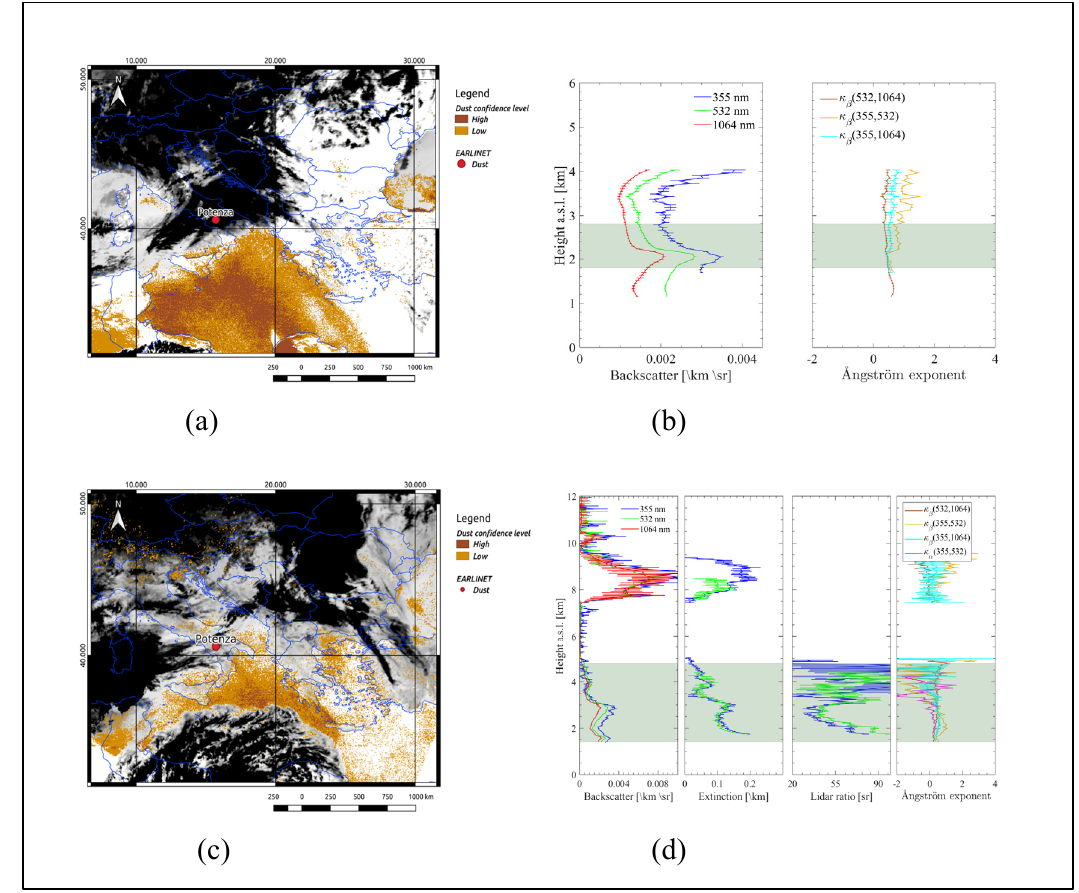
Figure 3. ( a ) e RST DUST map of May 18 at 10:00 UTC. ( b ) Potenza EARLINET aerosol backscatter coefficient and Angstrom exponent profiles acquired the same day between 09:55 − 10:30 UTC. The green zone indicates the dust affected portion of the profile; ( c ) e RST DUST map of May 18 at 21:00 UTC. ( d ) Potenza EARLINET aerosol backscatter coefficient, extinction coefficient, lidar ratio and Ångström exponent profiles acquired the same day between 21:46 − 22:15 UTC. The green zone indicates the dust affected portion of the profile.